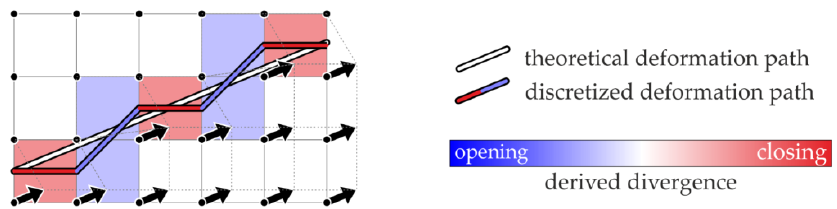
Figure 9. Artificial patterns of opening and closing generated by the discretization of the deformation path and the resulting angle between deformation feature and drift vectors.